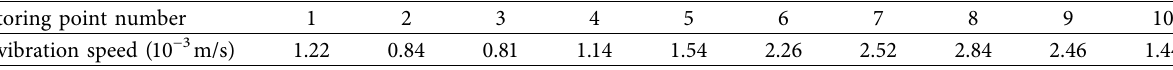
Table 2: The peak vibration velocity of X direction of each point in roadway.